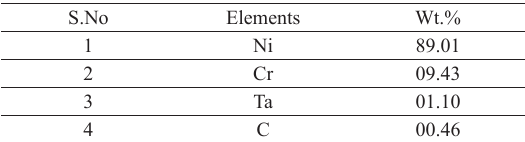
Table 1. Chemical elements of chromel